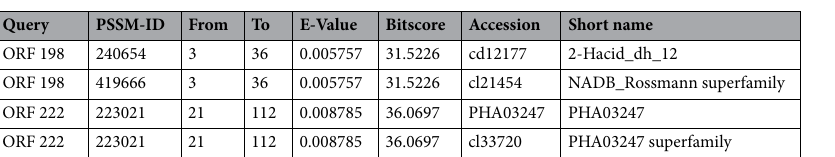
Table 3. circRNA_06424 sequence ORFs coding ability prediction information.